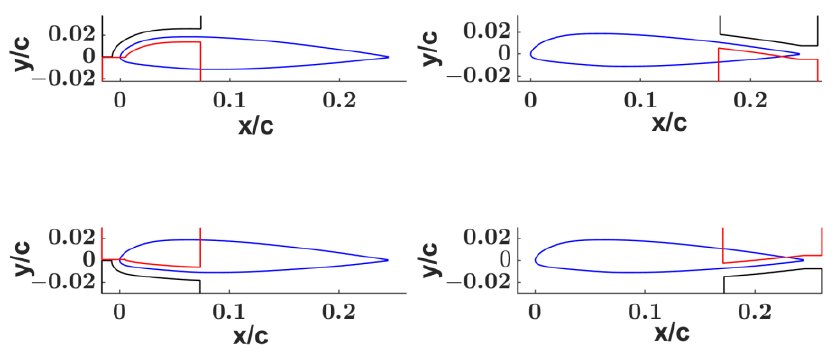
Figure 37. NACA 23012 skin deformation segments bounds defined by the user. Figure 38 represents the evaluated Pareto front skin optimization where the zero value on the obj.1 axis represents the equality of the aerodynamic efficiency between the global and skin-morphed airfoil. The obj.1 negative values represent airfoils with improved E. Table 17 reports the comparison between the aerodynamic/geometric properties of the not-deformed NACA2312 and the global and local morphed one. The one with the highest E value and a circulation close to the global morphed with a tolerance of 1 × 10 − 3 has been chosen for the skin-morphed